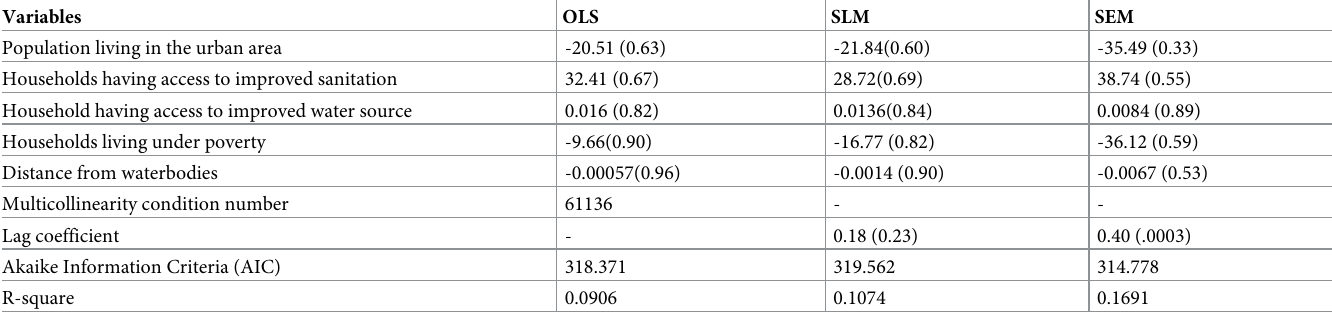
Table 4. Results of the different regression